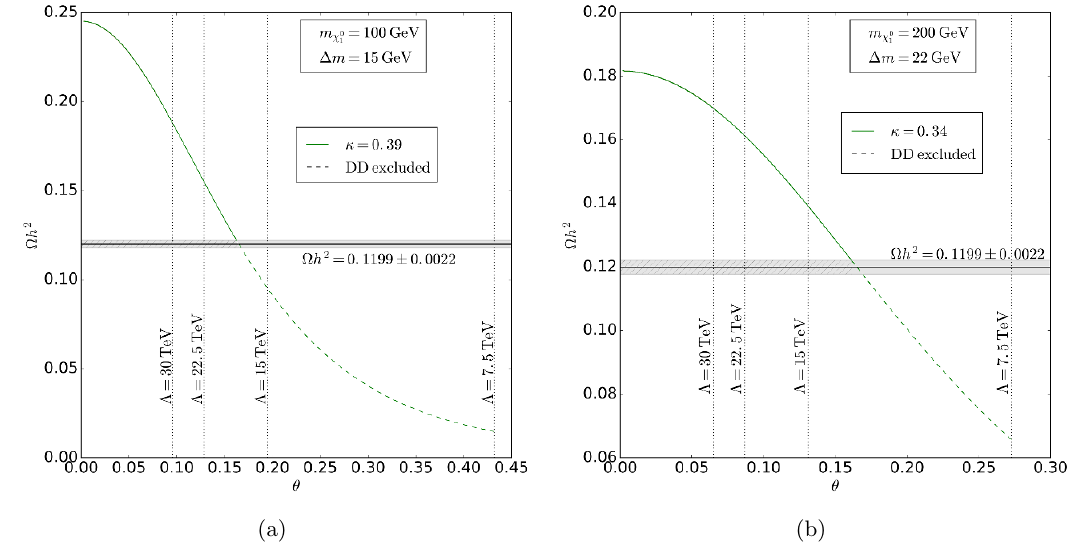
Figure 2 . Thermal relic density as a function of the singlet-triplet mixing angle (cid:18) for a WIMP mass of m = 100 GeV (left panel) and m = 200 GeV (right panel). For a (cid:12)xed Wilson coe(cid:14)cient (cid:21) = (cid:31) 0 1 (cid:31) 0 1